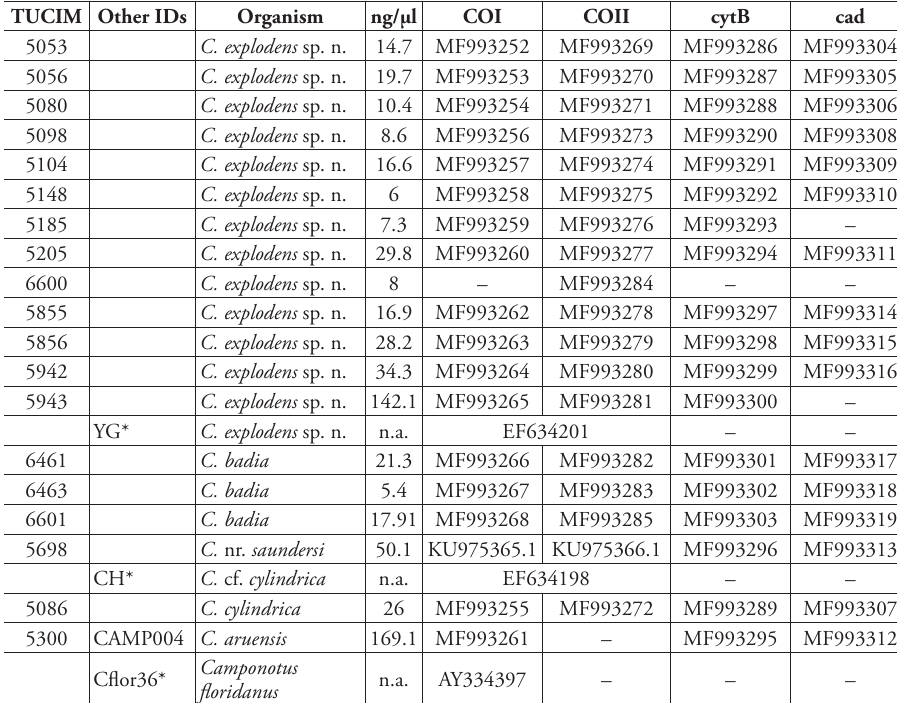
Table 2. List of sequence accession numbers in NCBI GenBank. * Nucleotide sequences from NCBI